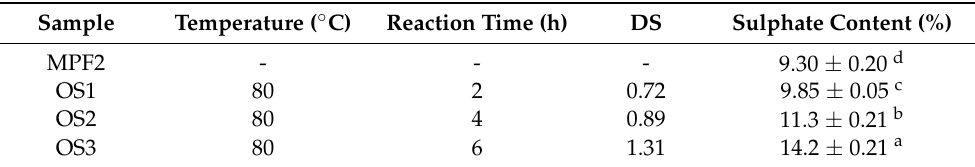
Table 2. Preparation conditions for over-sulphation (OS1, OS2, and OS3) and sulphate content of MPF2 and its derivatives from A. hemibapha .